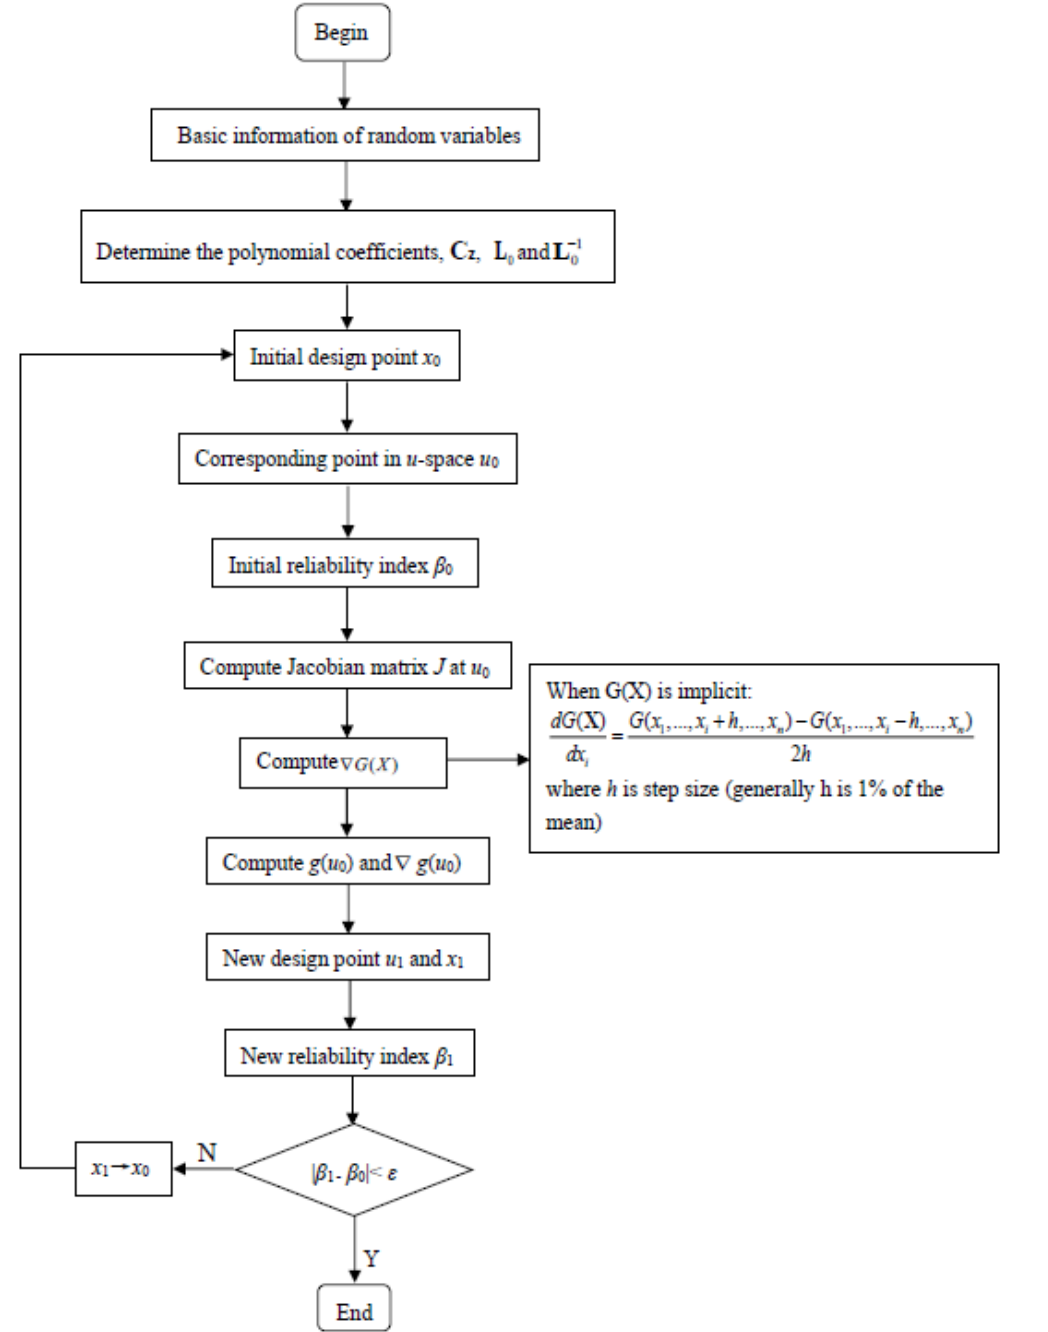
Figure 2. Procedure of FORM using the proposed